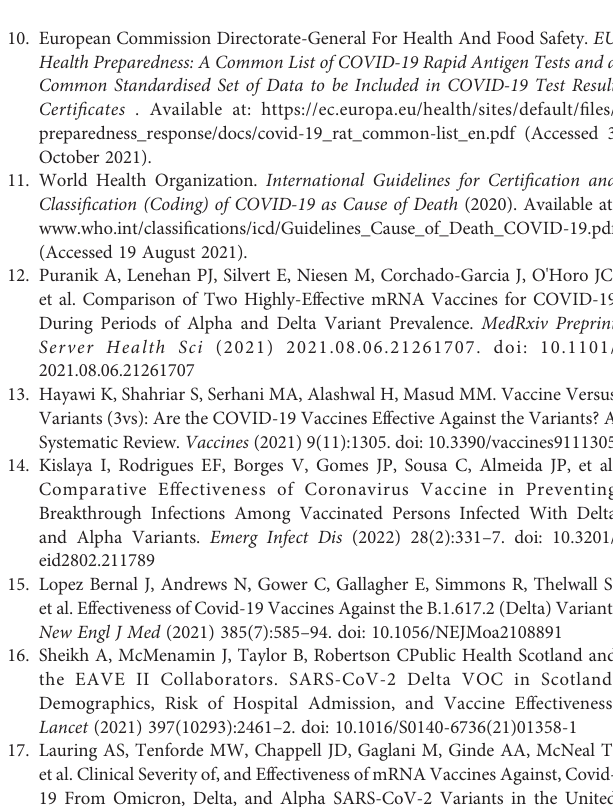
Supplementary Table 2 | Incidence rates, crude and adjusted effectiveness rates of vaccine combinations against registered SARS-CoV-2 infection during the Delta wave in the 18 – 64-year-old Hungarian population. Supplementary Table 3 | Incidence rates, crude and adjusted effectiveness rates of vaccine combinations against registered SARS-CoV-2 infection during the Delta wave in the 65 – 100-year-old Hungarian population. Supplementary Table 4 | Incidence rates, crude and adjusted effectiveness rates of vaccine combinations against Covid-19 related hospitalization during the Delta wave in the 18 – 64-year-old Hungarian population. Supplementary Table 5 | Incidence rates, crude and adjusted effectiveness rates of vaccine combinations against Covid-19 related hospitalization during the Delta wave in the 65 – 100-year-old Hungarian population. Supplementary Table 6 | Incidence rates, crude and adjusted effectiveness rates of vaccine combinations against Covid-19 related mortality during the Delta wave in the 18 – 64-year-old Hungarian population. Supplementary Table 7 | Incidence rates, crude and adjusted effectiveness rates of vaccine combinations against Covid-19 related mortality during the Delta wave in the 65 – 100-year-old Hungarian